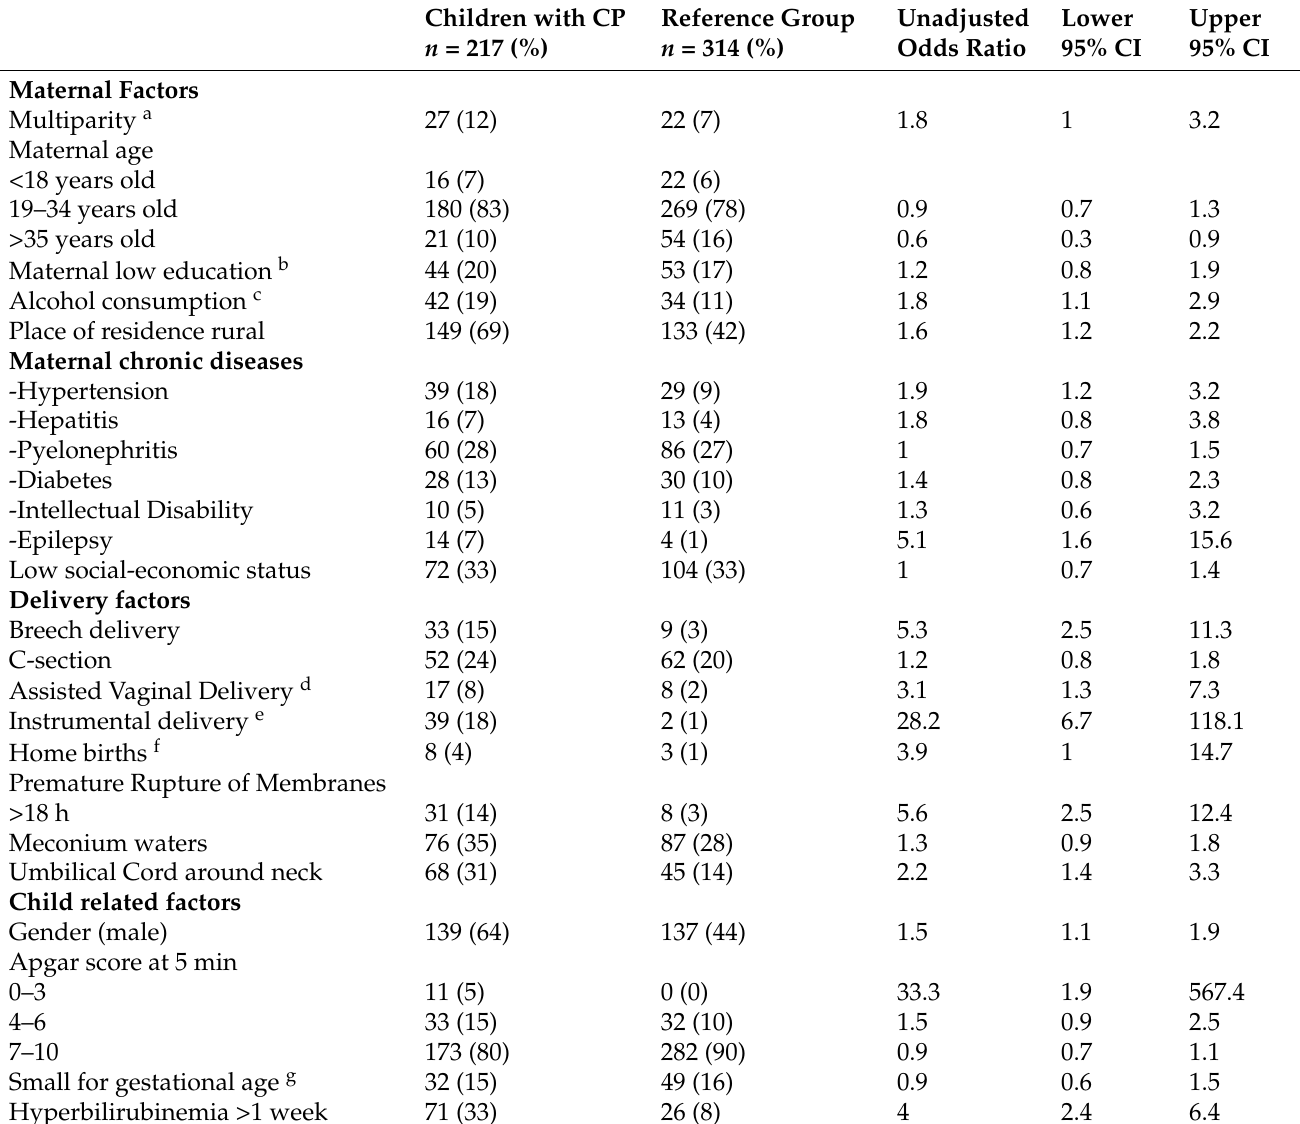
Table 5. Characteristics of singletons at term with cerebral palsy (CP) compared to the reference